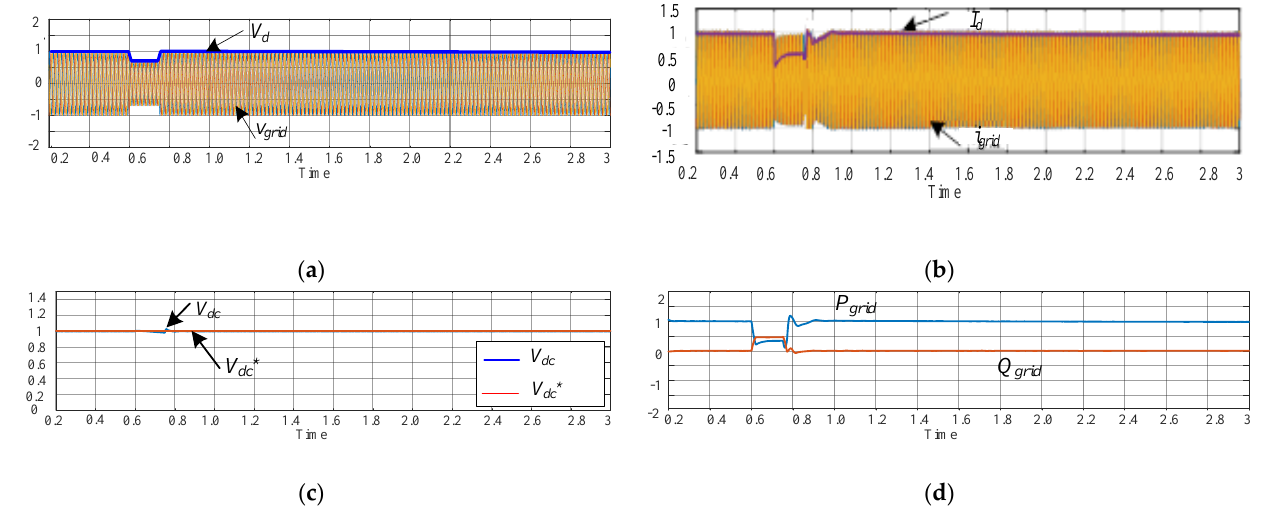
(p.u); ( d ) grid active power dc